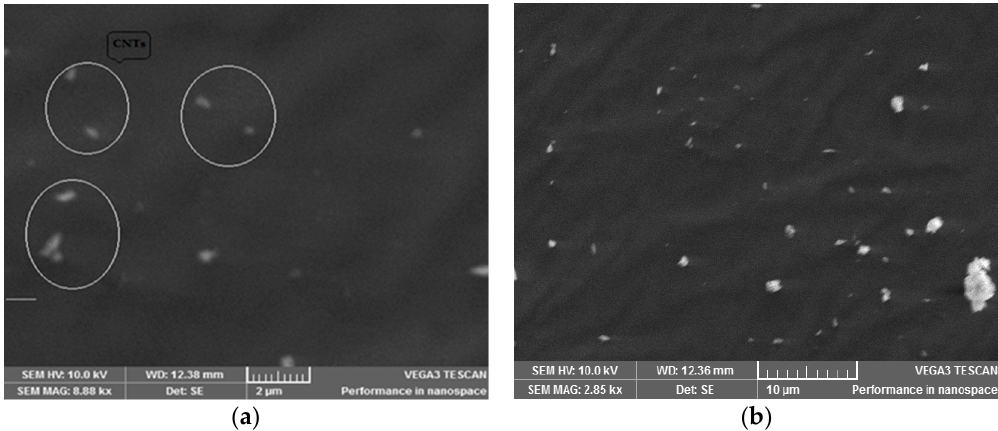
Figure 5. CNTs dispersion in bitumen using high shear mixer at different magnifications.